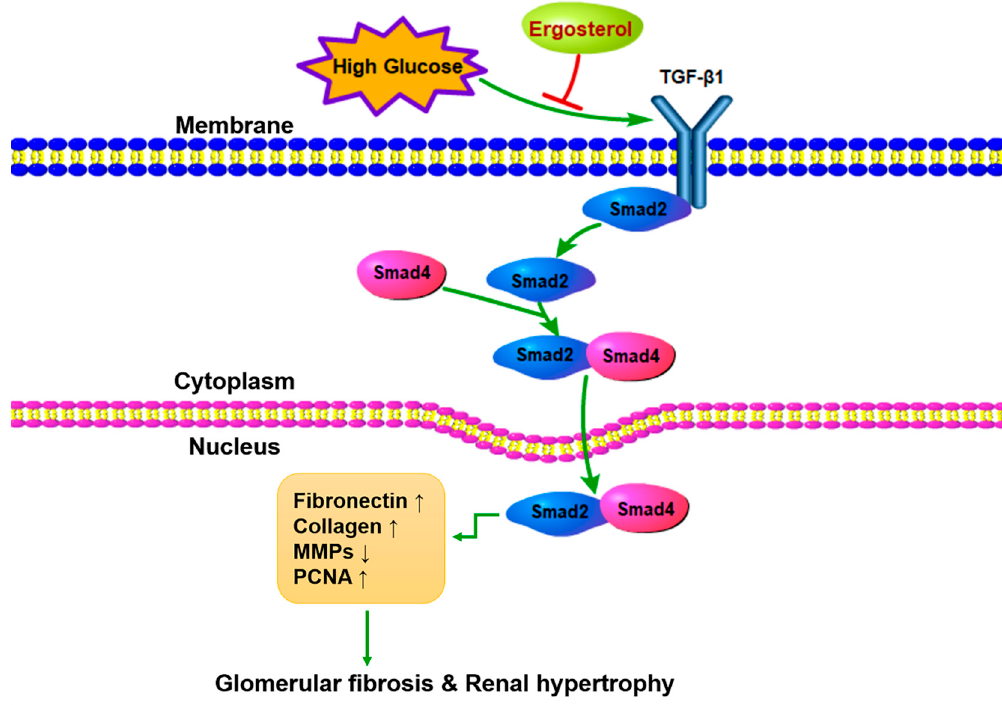
Figure 9. Schematic diagram shows the therapeutic effects of ergosterol on diabetic nephropathy.